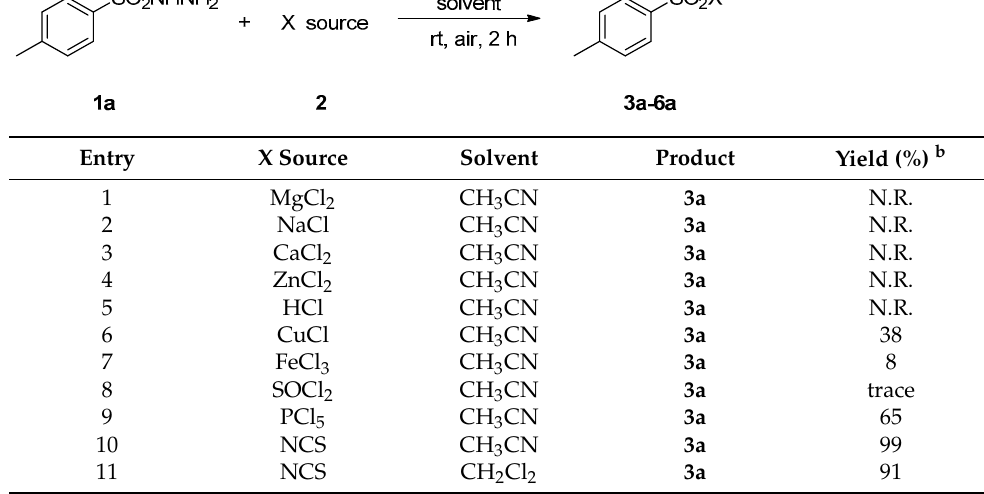
Table 1. Optimization of reaction conditions a .